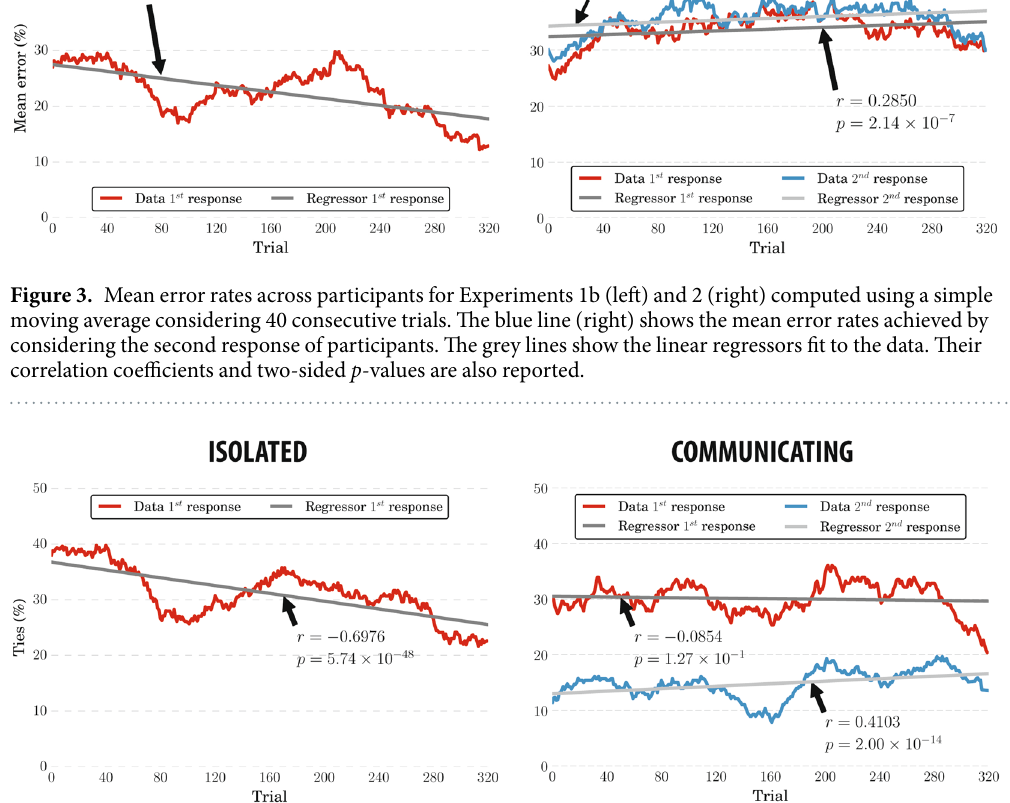
Figure 4. Percentage of trials resulting in a tie, pair members disagreeing on the corresponding decisions (individual points are computed using a moving average across 40 consecutive trials). The values are averaged across the 45 pairs formed with participants of Experiment 1b (left) and the 7 pairs recorded in Experiment 2 (right). The grey lines show the linear regressors fit to the data with their correlation coefficients and two-sided p